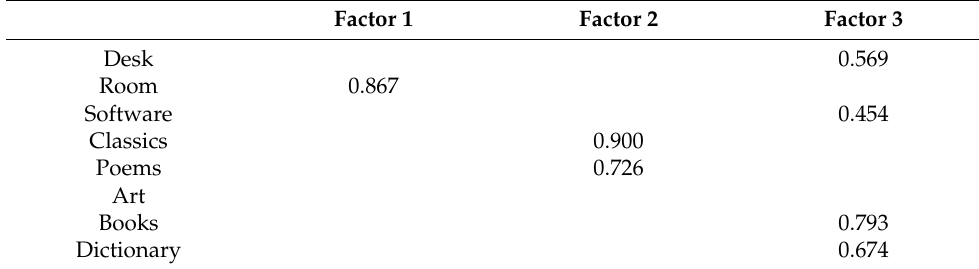
Table 2. Exploratory factor analysis results for home possessions and SES (oblique quartimax